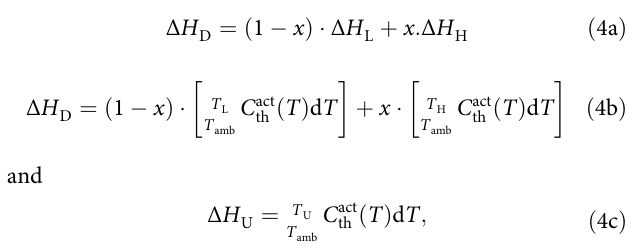
respectively, where C act is the thermal capacitance of only the th active NbO 2 layer within the device structure, Δ H L and Δ H H are the enthalpy changes from ambient corresponding to regions with temperatures T L and T H , respectively, and T amb is the ambient temperature (300 K). Figure 1i shows that the decom- posed con fi guration has a lower enthalpy at steady state. Criteria based on maximization of entropy or minimizing total heat